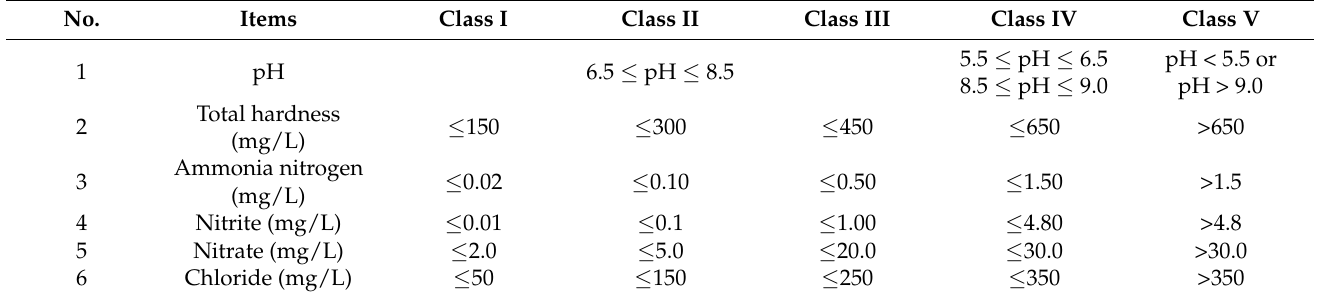
Table 1. Some of the chemical component content limits in the Groundwater Quality